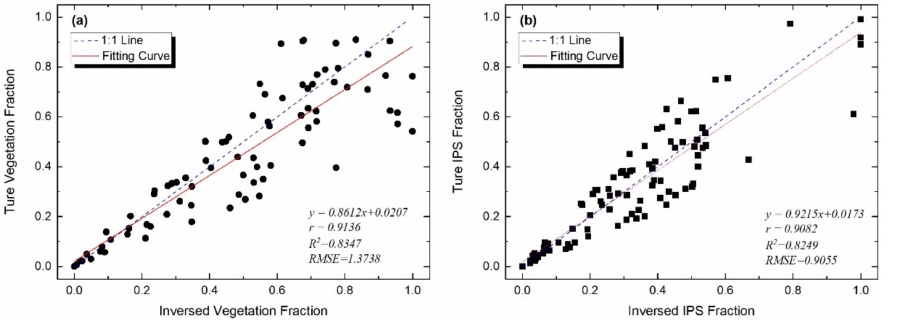
Figure 4. Validation of endmember fraction inversion results. ( a ) Accuracy of inversed vegetation fraction; ( b ) accuracy of inversed impervious surface fraction.